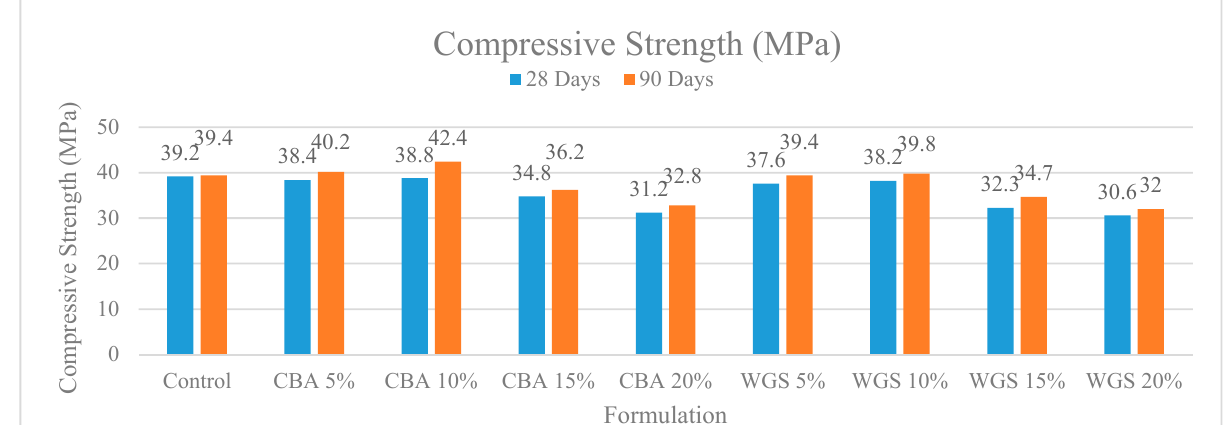
Figure 1. Comparison chart of compressive strength of concrete at 28 and 90 days.